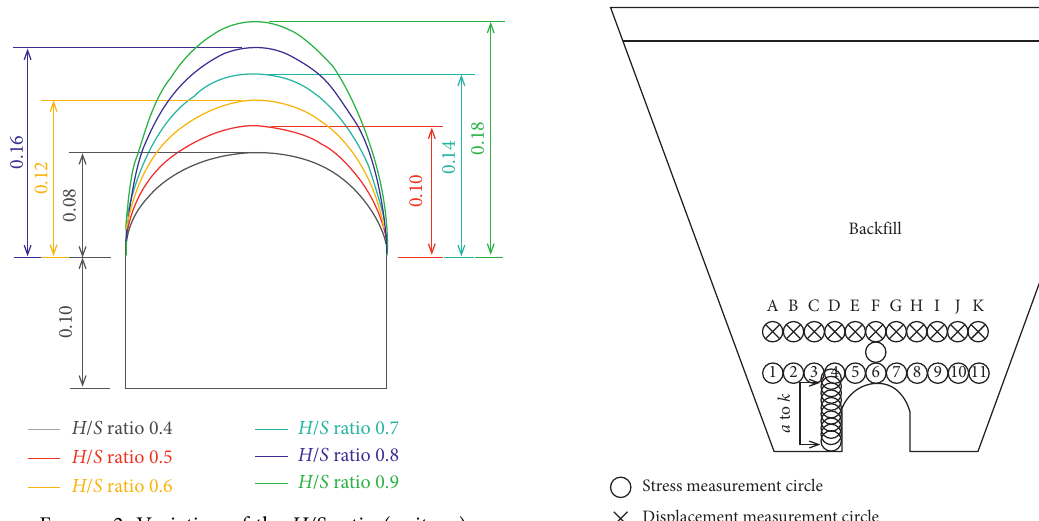
Figure 2: Variation of the H/S ratio (unit: m).